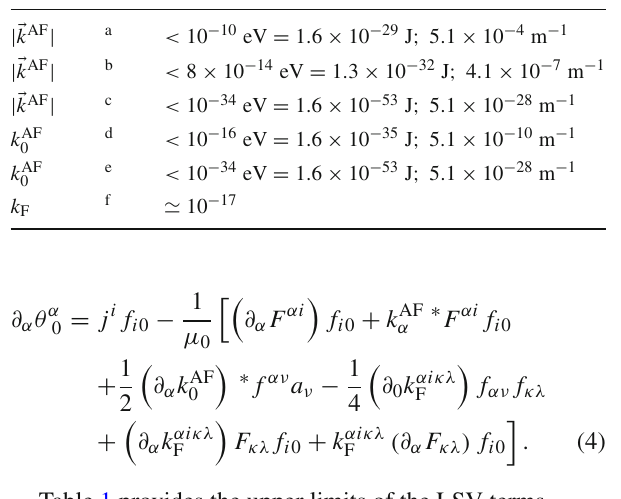
Table 1 Upper limits of the LSV parameters (the last value is in SI units). a Energy shifts in the spectrum of the hydrogen atom [11]; b Rotation of the polarisation of light in resonant cavities [11]; c , e Astrophysical observations [12]. Such estimates are close to the Heisenberg limit on the smallest measurable energy or mass or length for a given time t , set equal to the age of the universe; d Rotation in the polarisation of light in resonant cavities [11]. f Typical value